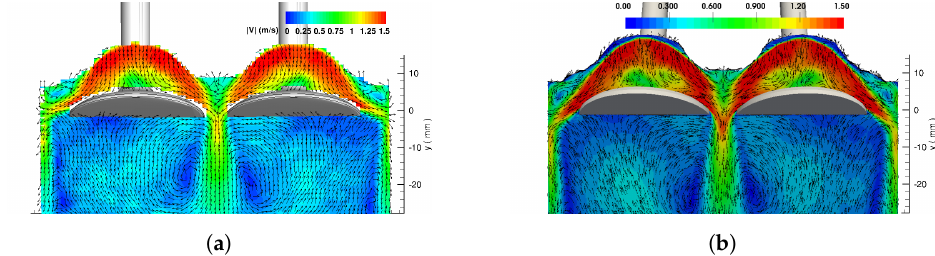
Figure 7. Comparison of velocity contour across both intake valves ( X = − 10 mm) in cross-tumble plane: complex flow structure between both valves and valve-cylinder